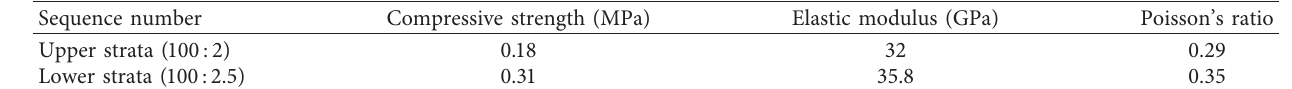
Table 3: Basic mechanical parameters of sand and paraffin mixed